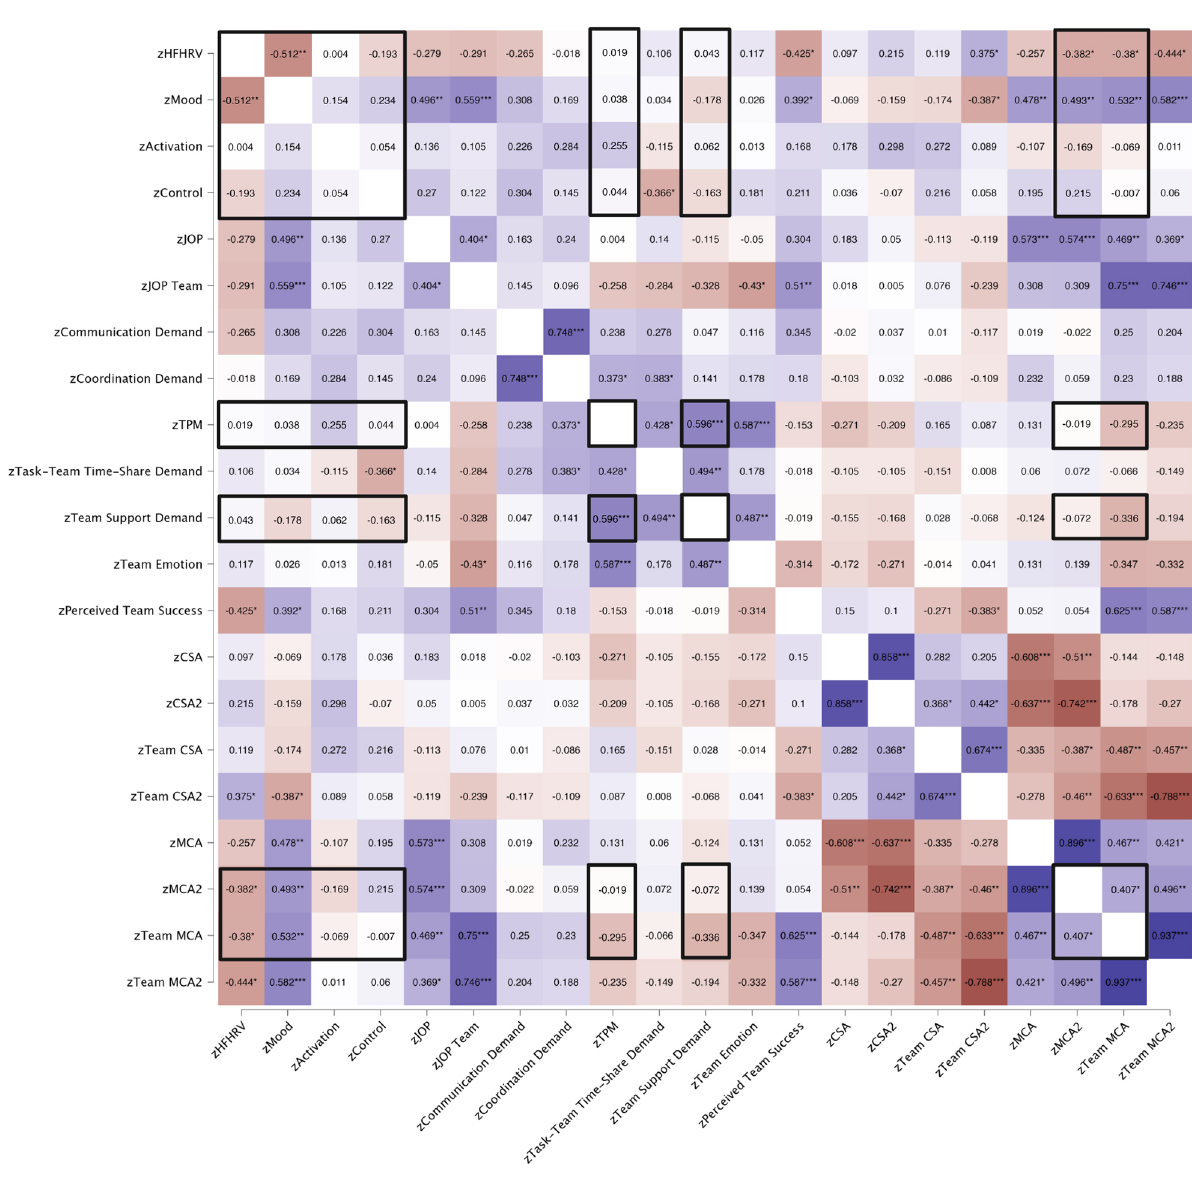
FIGURE4 Correlation heat map for HRV, SAM, team workload questionnaire, JOP, CSA, and MCA variables. 2-tailed. * p < 0.050, ** p < 0.010, *** p < 0.001. Matrix numbers are Pearson correlation coefficients ( r ) and Spearman’s correlation coefficients ( ρ ). Pearson’s r is indicated with black frames. Red, Negative correlation; Blue, Positive correlation. Color intensity indicates the strength of correlation. HFHRV, High frequency component heart rate variability; JOP, Judgment of performance; TPM, Team performance monitoring; CSA, Cyber situational awareness; MCA, Metacognitive accuracy; CSA2 and MCA2, CSA and MCA without Kill chain